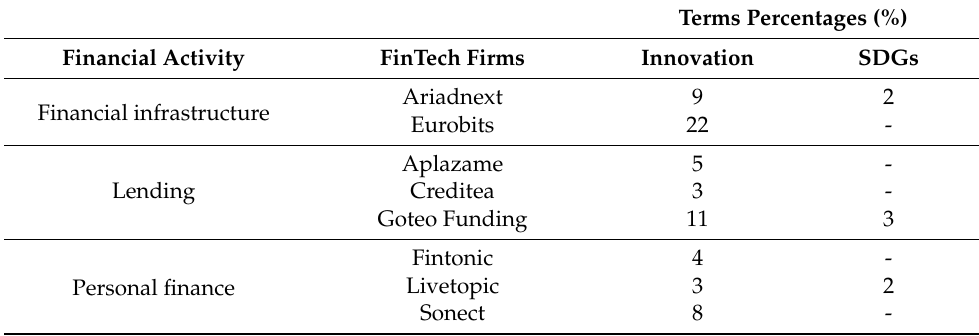
Table 3. The percentage of innovation and SDG topics in fields with major appearances.